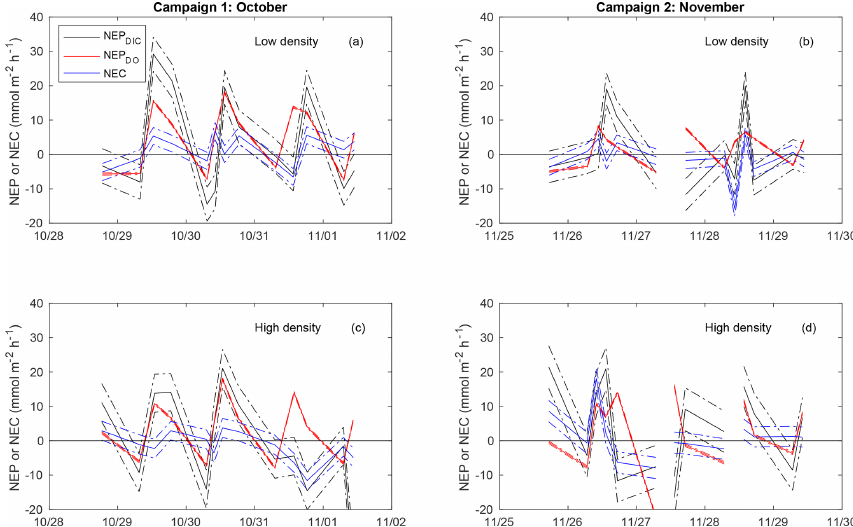
Figure 5. Time-series plot of NEC (blue), NEP DIC (black), and NEP DO (red), including the upper and lower uncertainty bounds related to error due to advection (dashed